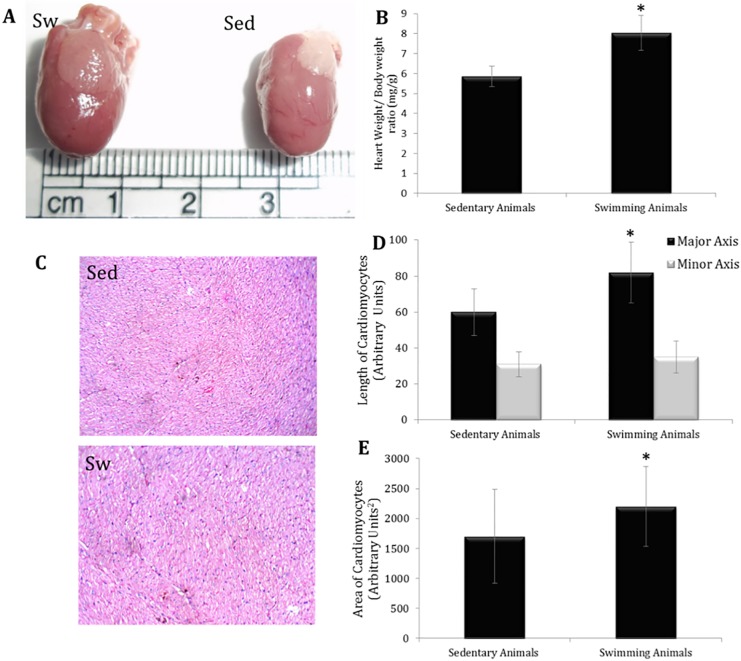
Assessment of induction of physiological cardiac hypertrophy.A. Representative photographs of the hypertrophied and control heart B. Heart weight/ body weight ratio. C. Representative histopathology images of hypertrophied and control cardiomyocytes. D. Cell profiler analysis of cell length and area of the cardiomyocytes. The values represent the mean±SD of six animals. Asterisk represents the statistical significance by Mann-Whitney U test at p-value < 0.005